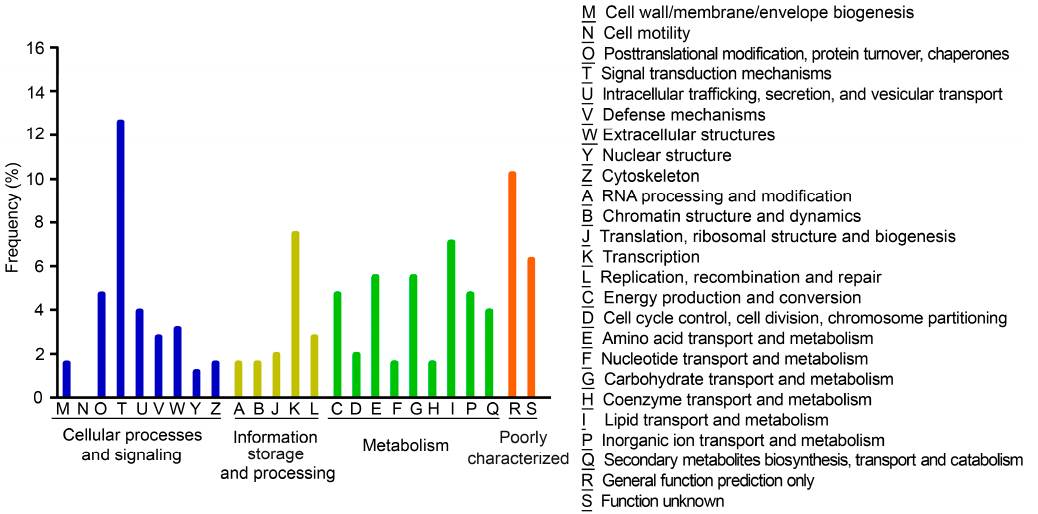
Figure 6. Functional assignments to the KOG categories. The graph shows the assignment of the targets of the nitrogen deficiency-responsive miRNAs in C. reinhardtii to the 25 categories of the eukaryotic orthologous groups of proteins (KOG). The main KOG categories are represented in different colors. The nitrogen deficiency-responsive miRNAs included 19 known miRNAs and 10 novel miRNAs.